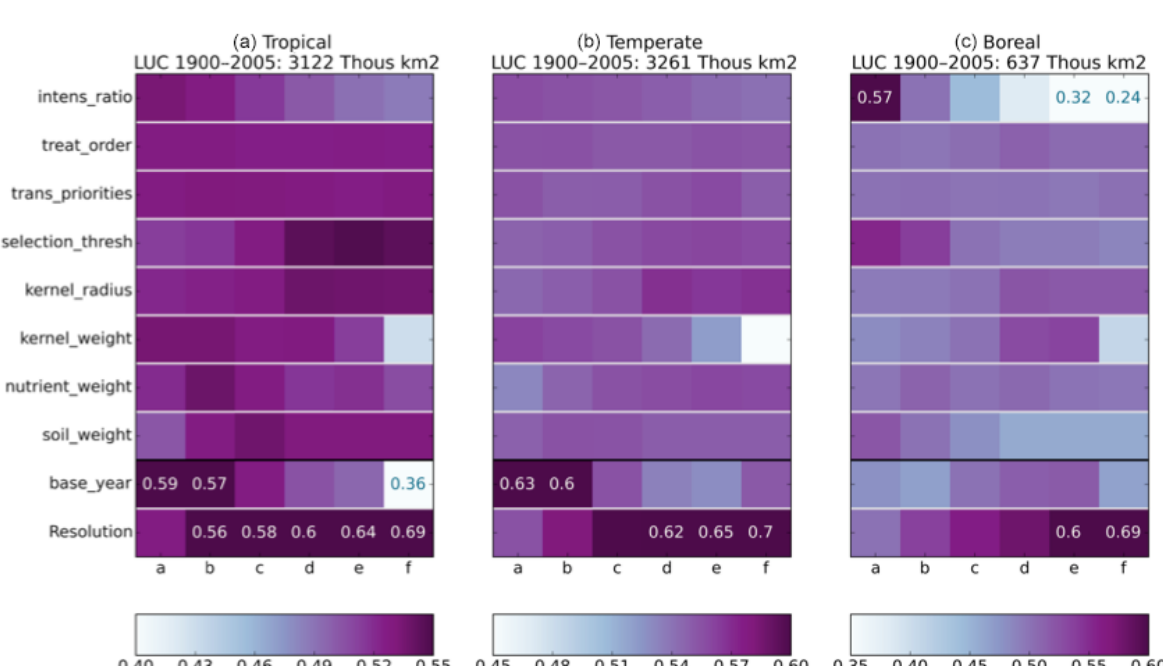
Figure 6. Results of the performance and sensitivity analysis for crops. For the six alternative values ( x axis) of each parameter ( y axis), the color scale indicates the land use downscaling performance metric averaged over all grid cells in the (a) tropical, (b) temperate, and (c) boreal biomes. Colorbar ranges are different for each biome. Beyond-range values are printed in the corresponding x,y position (the full scale of the metric is [− 1 , 1 ] ; see text). Note: the figure uses a perceptual colormap with monotically decreasing lightness throughout the colormap. Equal changes in the evaluation metric anywhere are perceived as equal steps in the color